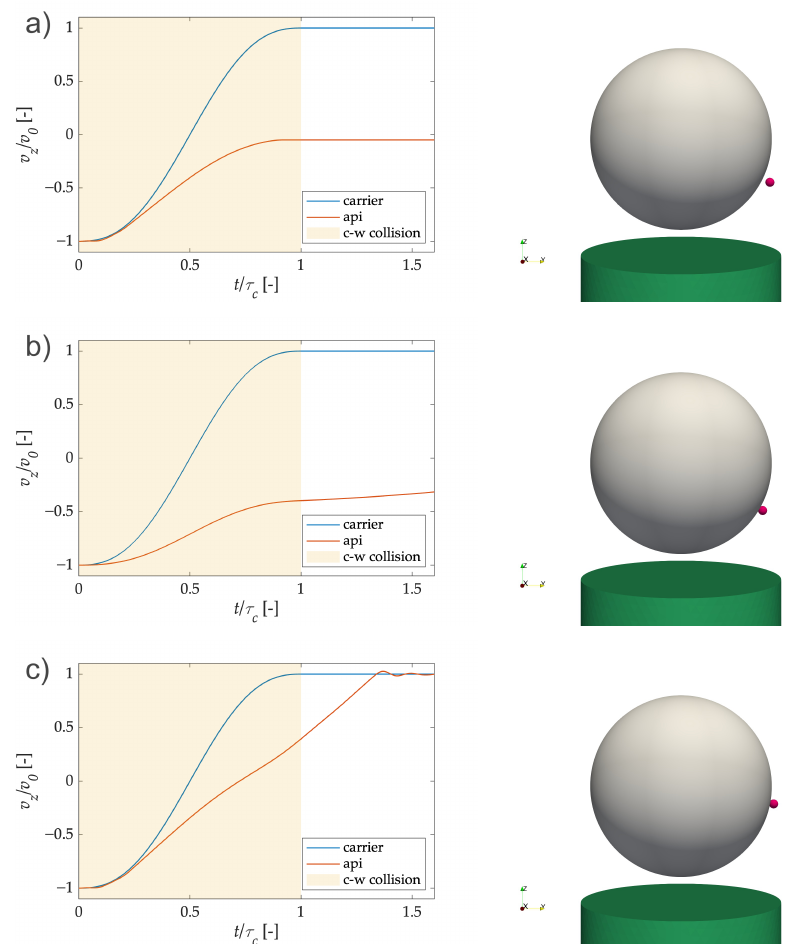
Figure 4. Carrier and API dimensionless velocity profiles during wall collision and particle position after impact (at t = 1.6 τ c ) in three cases: ( a ) detachment of API particle, ( b ) no detachment of API particle without rolling friction, ( c ) no detachment of API particle with rolling friction. The shaded area indicates carrier contact with the wall.